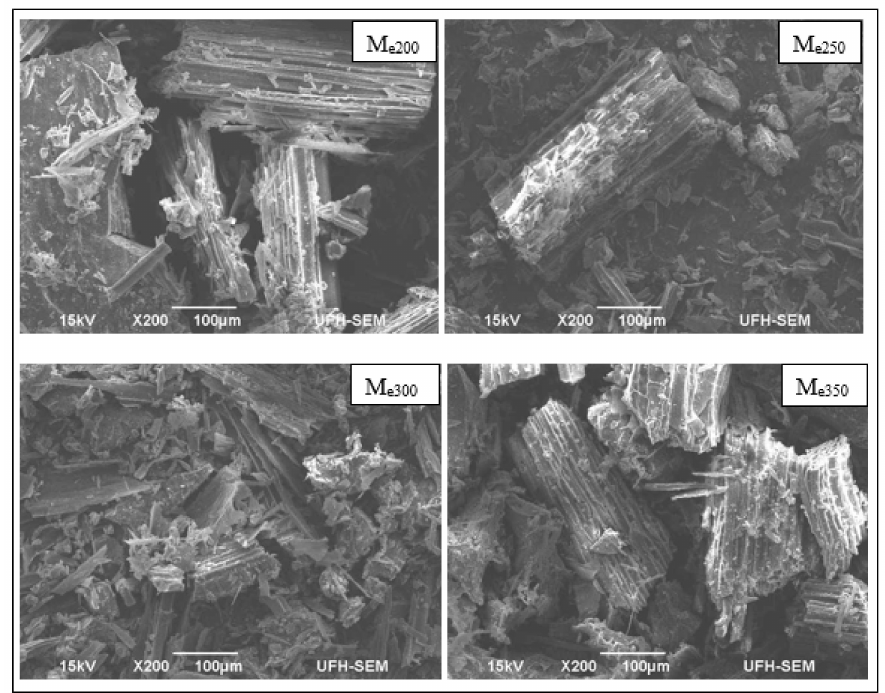
Figure 4. SEM images of 75% SS to 25% BG blended ratio of torrefied SS and